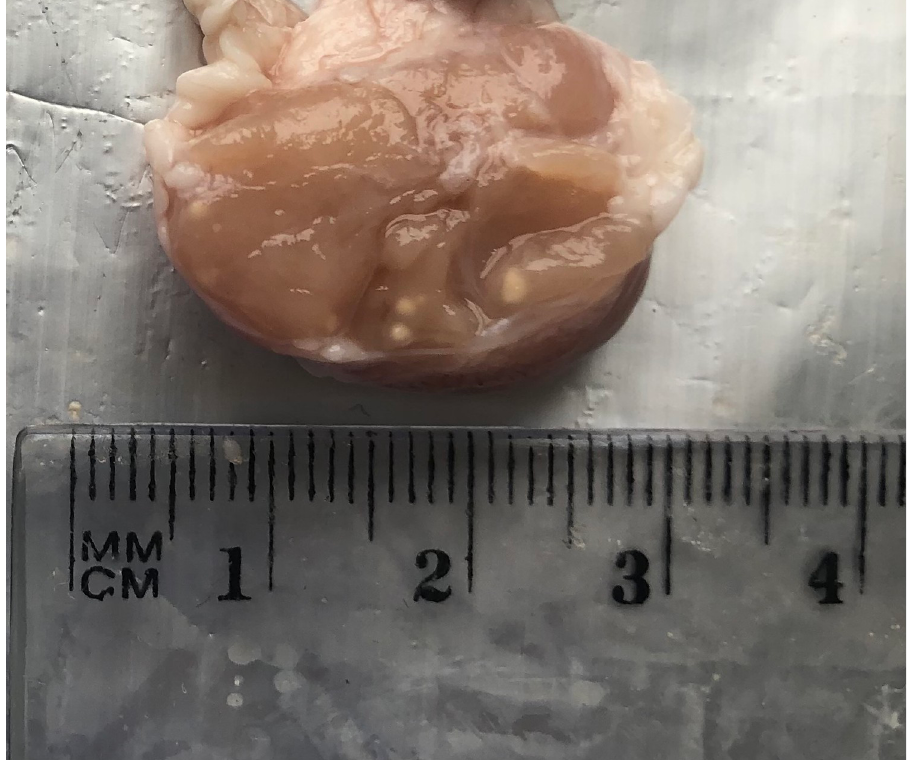
Fig 1. Mandibular lymph node with single lesions,